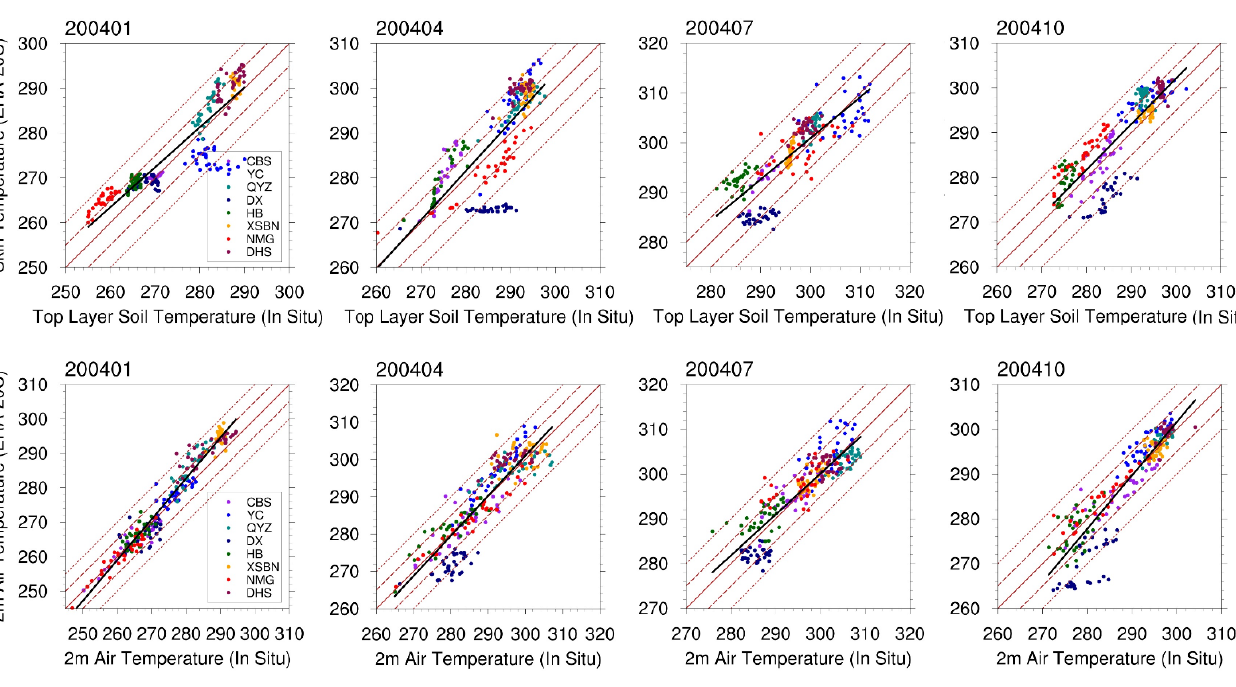
Figure 4. Scatterplots of the skin temperature, 2 m air temperature from ERA-20C against data from the 8 ChinaFlux sites. Overlapped are biases of the ± 5 K and ± 10 K lines (red dashed), the 1:1 line (red solid), and the linear regression line (black solid). Table 3. Validation of skin temperature, 2 m air temperature, and near surface relative humidity from ERA-20C against in situ measurements at the 8 ChinaFlux sites.